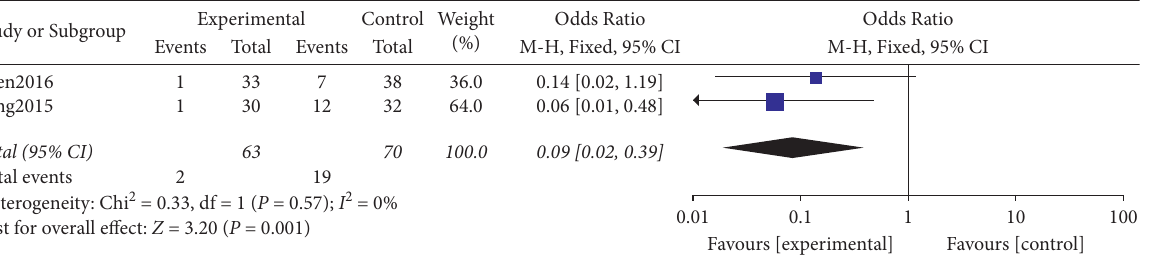
Figure 9: Postoperative ALOD.